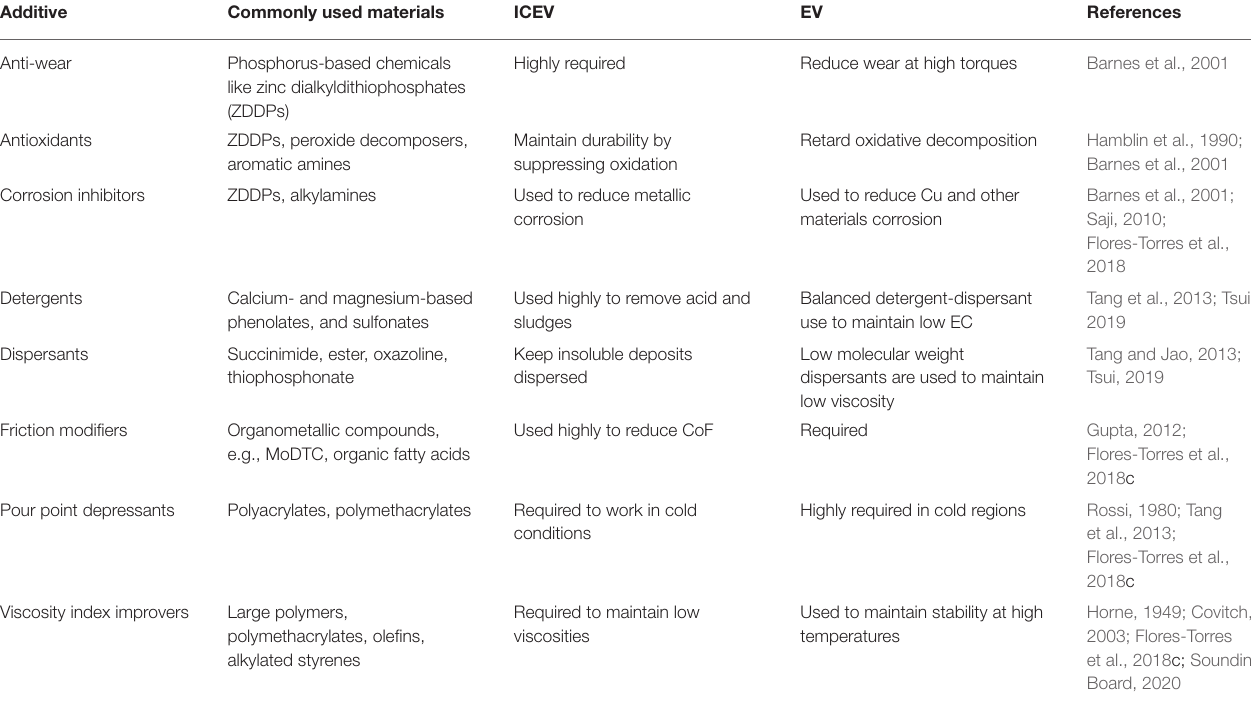
TABLE 5 | The characteristics of additives and their